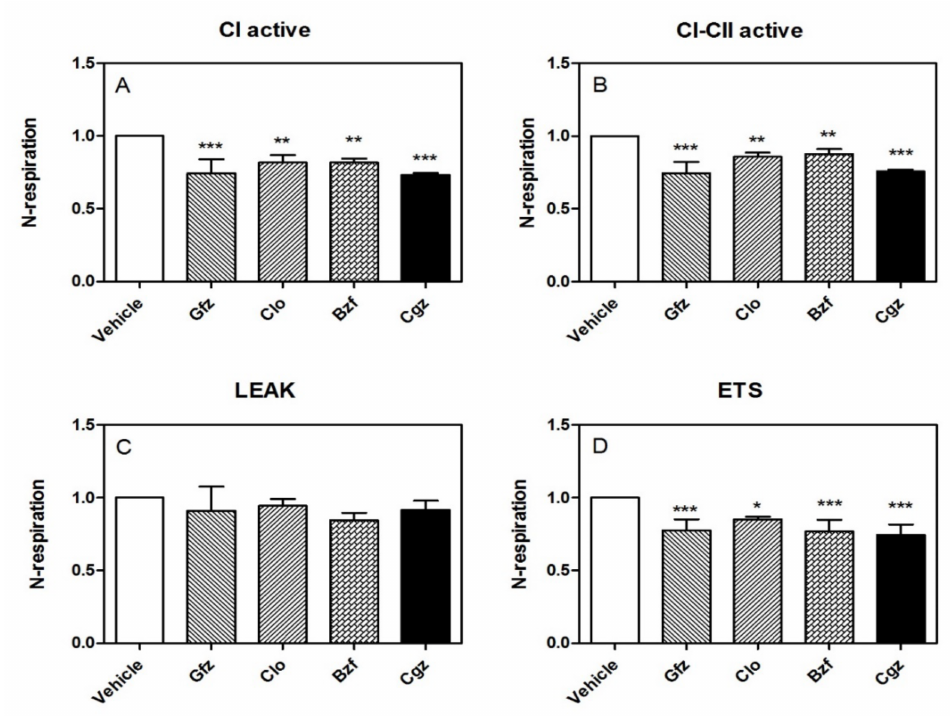
Figure 1. The effect of different PPAR ligands on CI and the respiratory states in permeabilized HepG2 cells. Respiration (indicated as the rate of oxygen flux normalized to the respective control) was evaluated at different stages. Panel ( A ): CI-active, CI respiration activated by excess ADP; Panel ( B ): CI/II-active, combined CI and CII respiration; Panel ( C ): Leak respiration, induced by the inhibition of ATP synthase by oligomycin; and Panel ( D ): ETS respiration, recorded in presence of the optimal FCCP concentration. Statistical analyses were performed with one-way ANOVA, followed by a multiple comparison of the means by a Dunnett test to calculate significance: * p < 0.05, ** p < 0.01, and *** p <